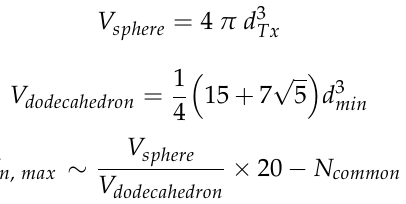
Figure 7. Dodecahedron: sided ( left ) and polyhedral ( right ) shape.